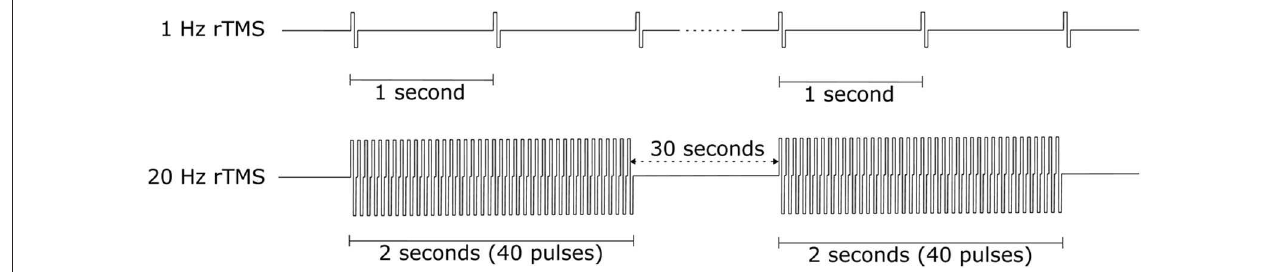
FIGURE 10 | rTMS protocol example.